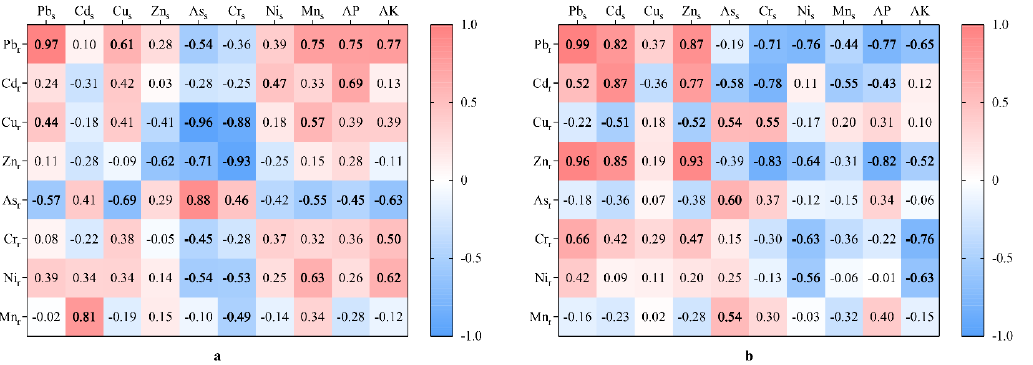
Figure 4. The Pearson correlation coefficients between plant root HM concentrations and soil HM, AP, and AK concentrations in the Jiulong iron tailing area ( a ) and Yangtiangang lead-zinc tailing area ( b ). The ‘s’ and ‘r’ in the subscript denote soil and root, respectively. Bold numbers indicate the statistically significant ones, and correlation is significant at the 0.05 level (2 − tailed).